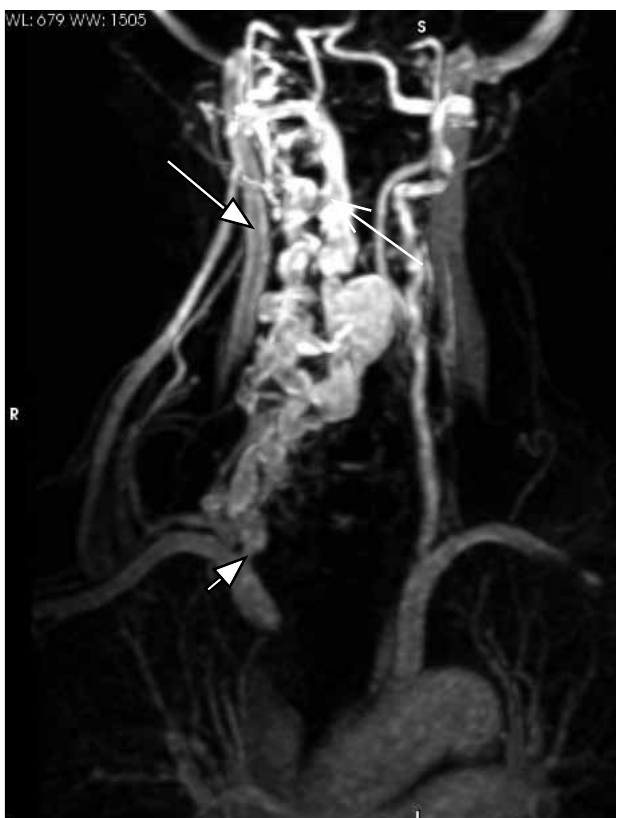
Fig. 3. MRA demonstrating the cervical spinal AVF fed by the right vertebral artery (arrow head). Note the engorged epidural vein (open arrow) and the right internal jugular vein (filled